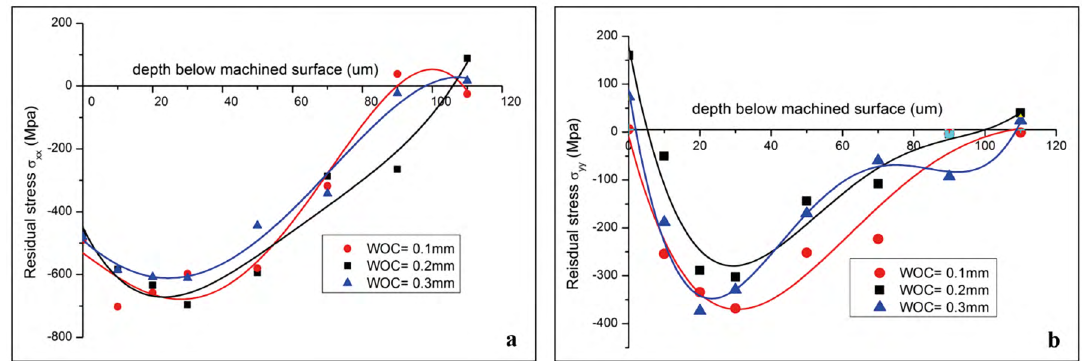
, (b) σ , ( a =0.3mm, V =60m/min, f =0.06mm/rev, lead angle=10°,tilt angle=0°, xx yy p eff